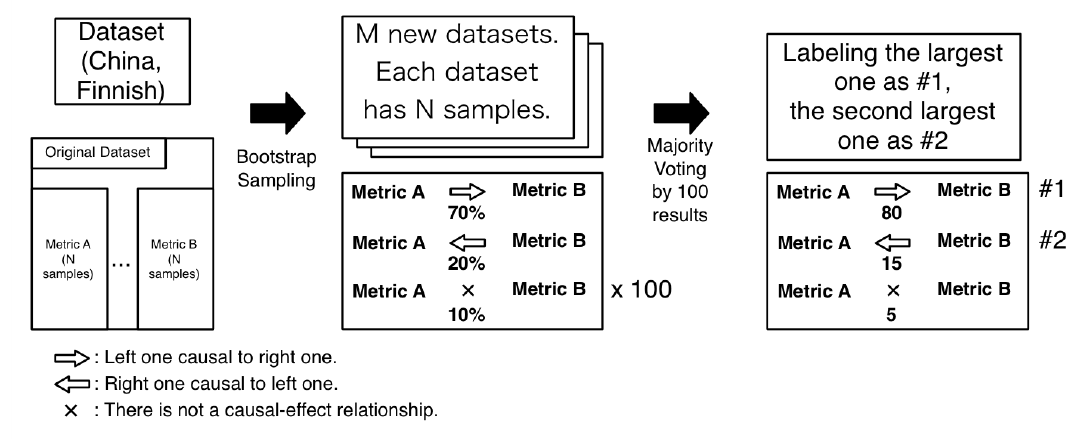
Fig. 10. Our experiment procedure for RQ3 (focusing on two